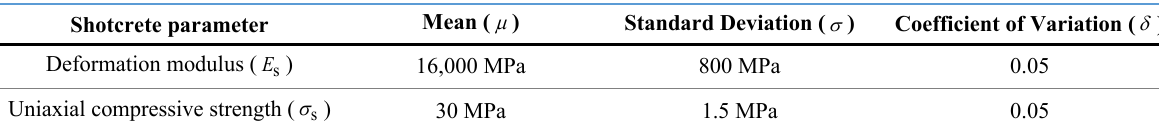
Table 3. Statistical parameters of shotcrete support